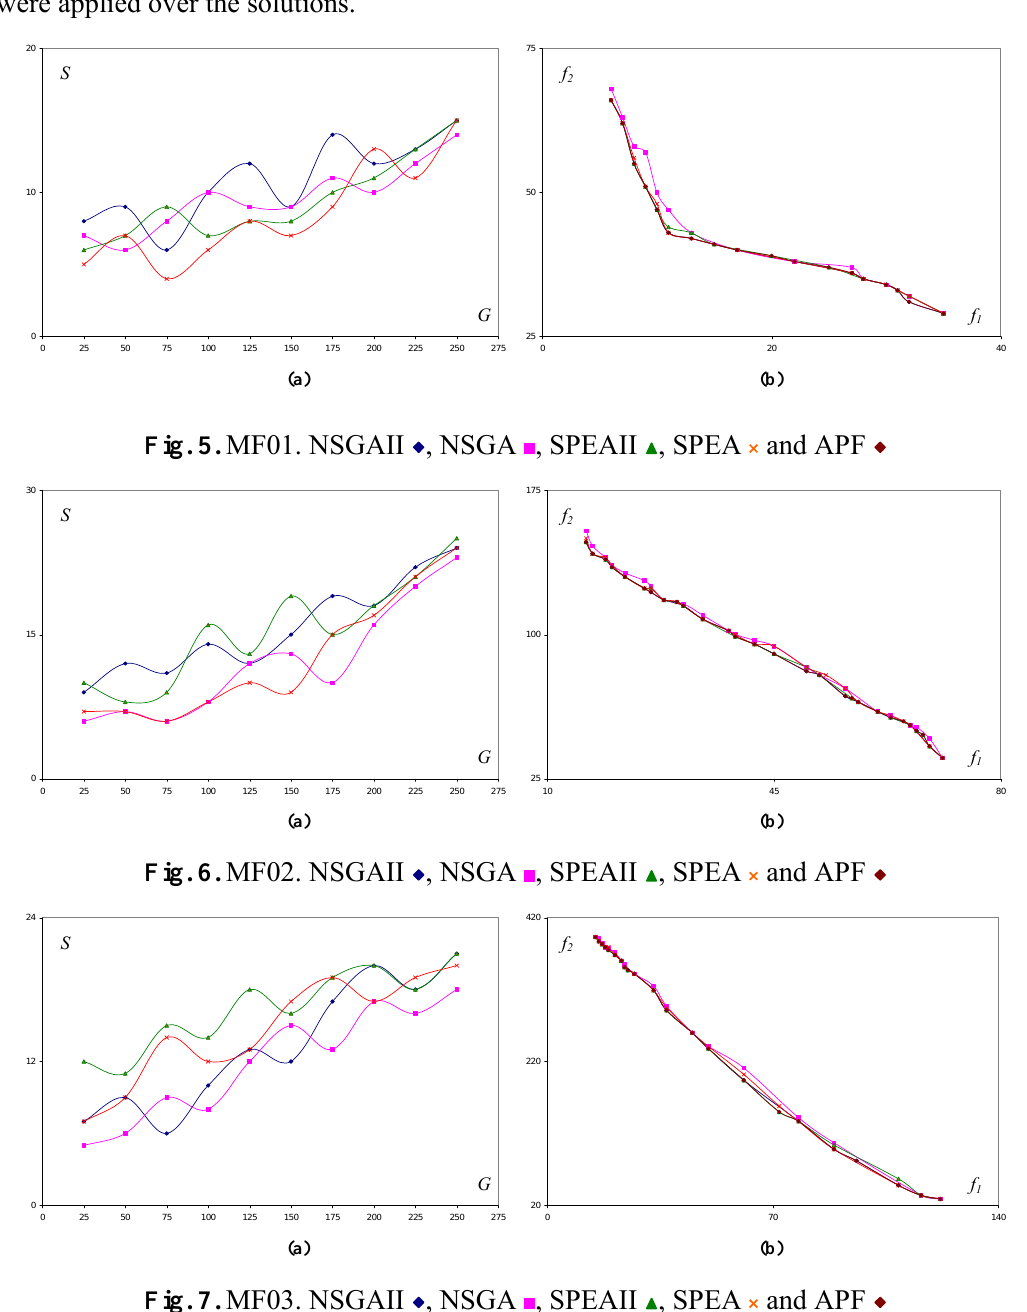
Fig. 7. MF03. NSGAII , NSGA , SPEAII , SPEA and